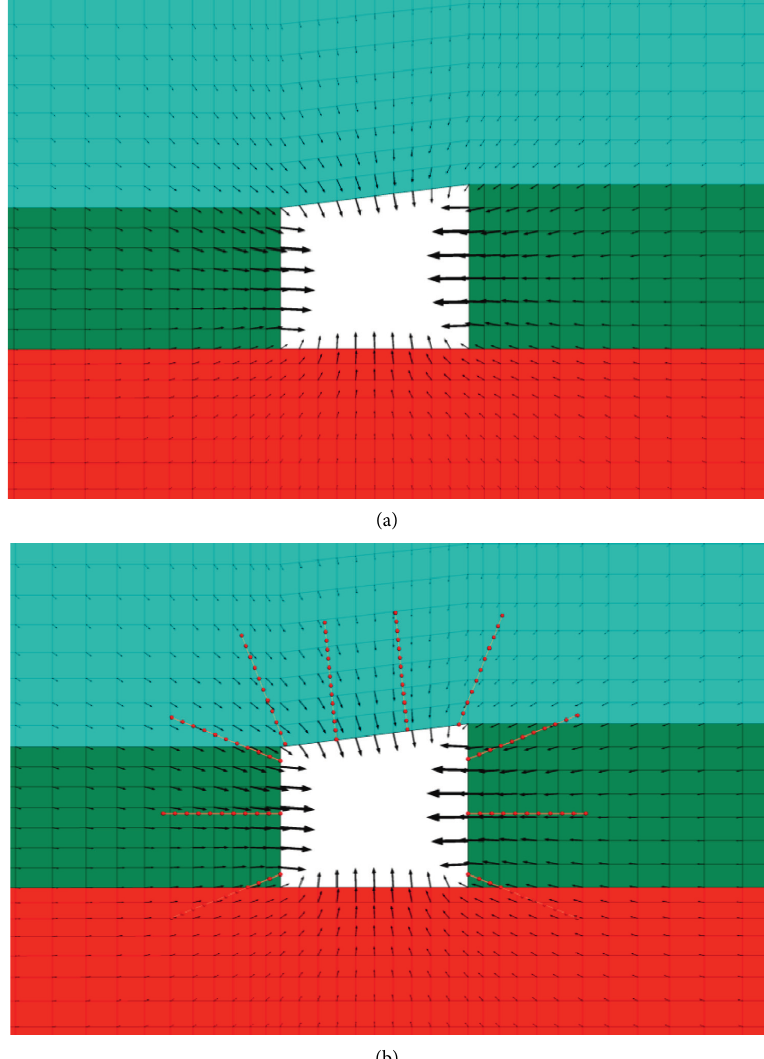
Figure 6: Vector diagram of deformation of surrounding rock: (a) original support and (b) reinforced support.